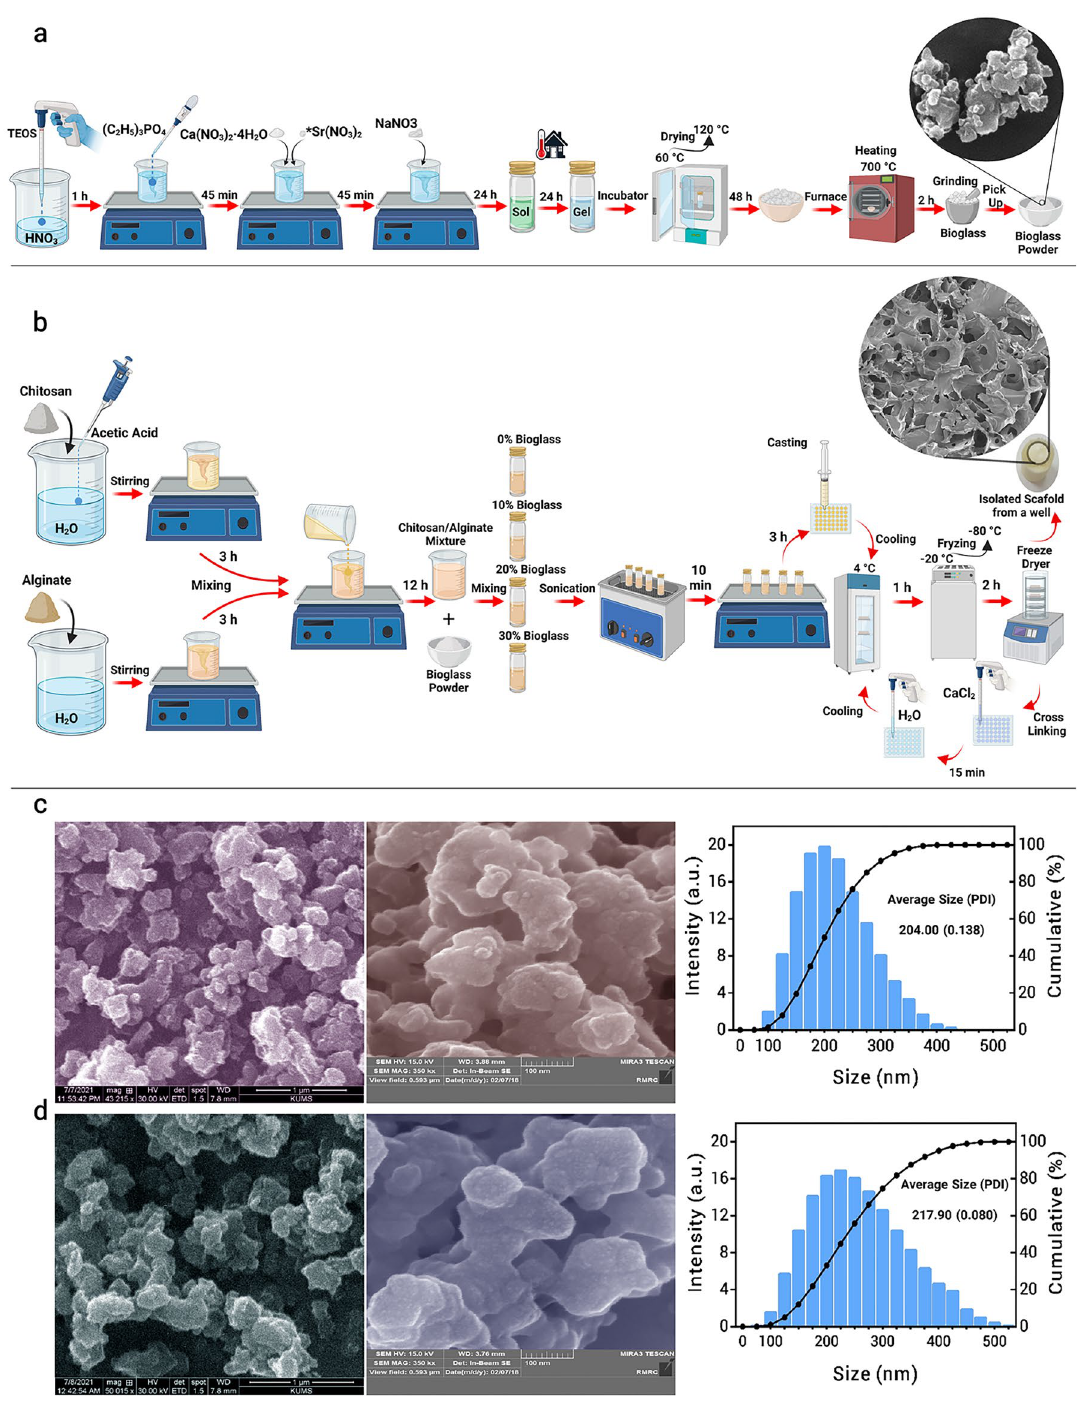
Figure 1. Fabrication scheme of bioglass/scaffolds and morphology and size distribution of synthesized bioglasses. ( a ) Bioglasses synthesis steps, ( b ) Scaffolds fabrication steps. ( c ) BG morphology and size distribution, ( d ) Sr-BG morphology and size distribution. The average size of synthesized bioglasses is in the nanometer